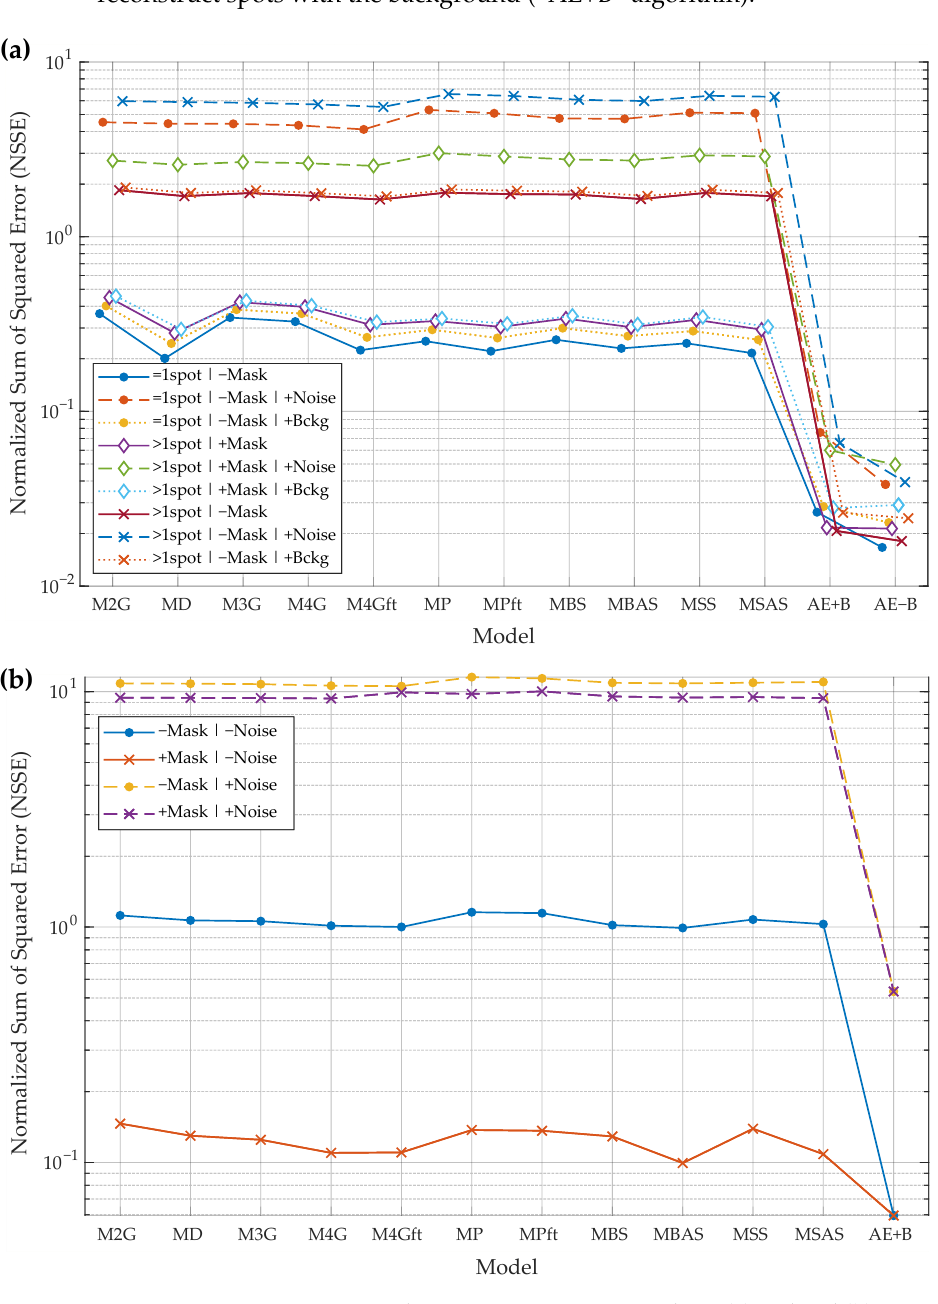
Figure 8. Protein spot reconstruction results: experiments using synthetic ( a ) and real ( b ) images of protein spots. Model performance is compared by normalized sum of squared error (NSSE) (lower is better). Models “M2G”–“MSAS” are the baselines, and “AE+B” and “AE − B” are the developed autoencoder-based spot models. Experimental cases: “=1spot”/“>1spot”—one or more spots in the input image; “+Mask”/“ − Mask”—spot mask is provided or not (mask is used by the baseline algorithms); “+Noise”/“+Bckg”—input images may be corrupted by Gaussian noise or by slowly varying background. Please refer to the text of Section 3 for more details on the models and for the description of the experimental case notation used in the